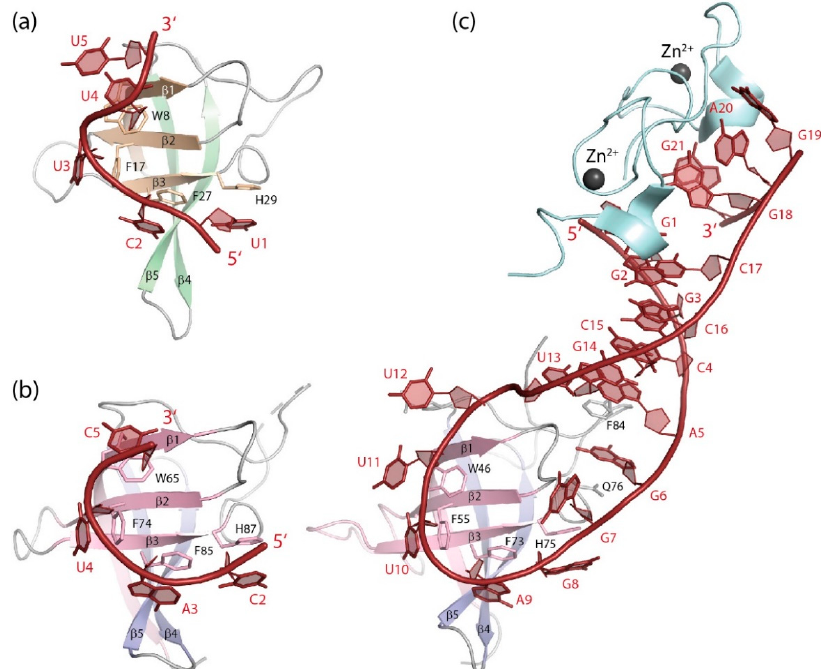
Figure 6. RNA single strands bound to CSDs. ( a ) GUCUUUA bound to Bs CspB ([139], PDB entry 3pf4). The 5 ′ and 3 ′ -terminal nucleotides of the co-crystallized RNA strand are not revealed in the structure. ( b ) UCAUCU bound to the YBX1 CSD ([11], PDB entry 5ytv). The 5 ′ and 3 ′ -terminal nucleotides of the co-crystallized RNA strand are not revealed in the structure. ( c ) The microRNA precursor preE M -let-7d bound to the CSD and ZKD of mouse LIN28A ([140], PDB entry 3trz). Drawings prepared with PyMOL